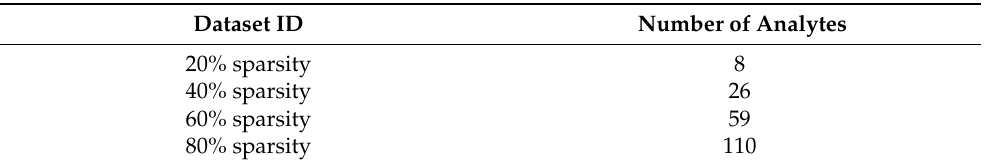
Table 1. Description of the created data subsets based on the percentage of sparsity and the resulting number of analytes